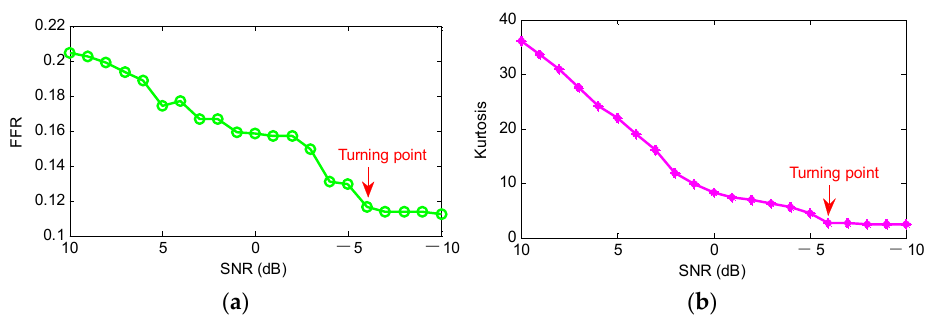
Figure 5. Quantitative analysis results obtained by the proposed method with increasing levels of noise: ( a ) FFR curve; ( b ) kurtosis